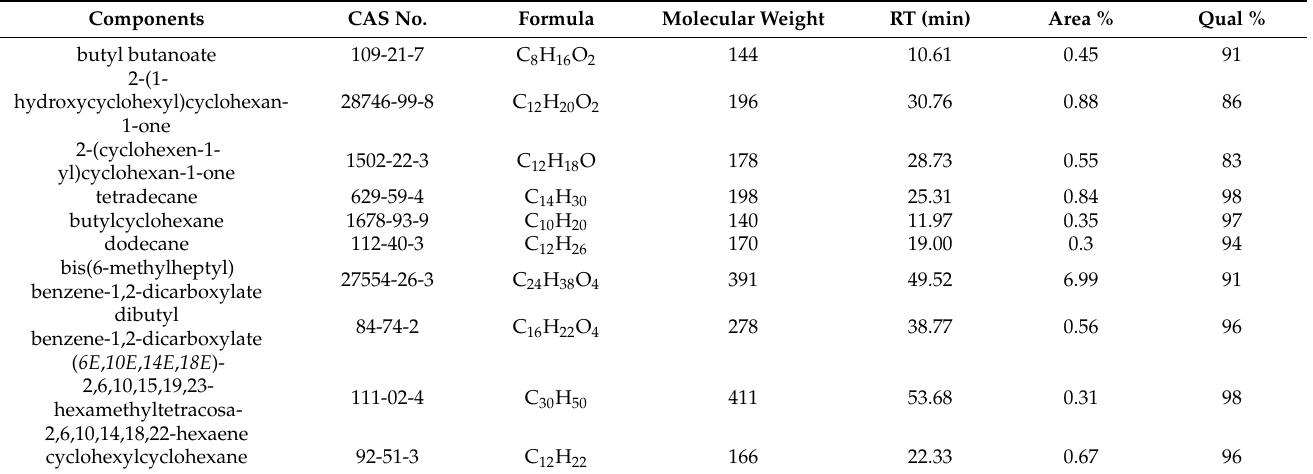
Table 1. The major 10 VOCs produced by B. diminuta